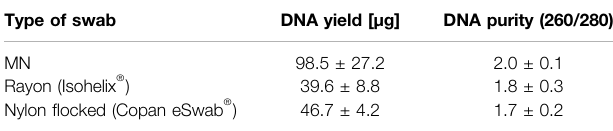
TABLE 3| Comparison ofDNA yield and purity ofMNswab(S-N3-I3-S7) and two commercial swabs (Isohelix ® and Copan eSwab ®